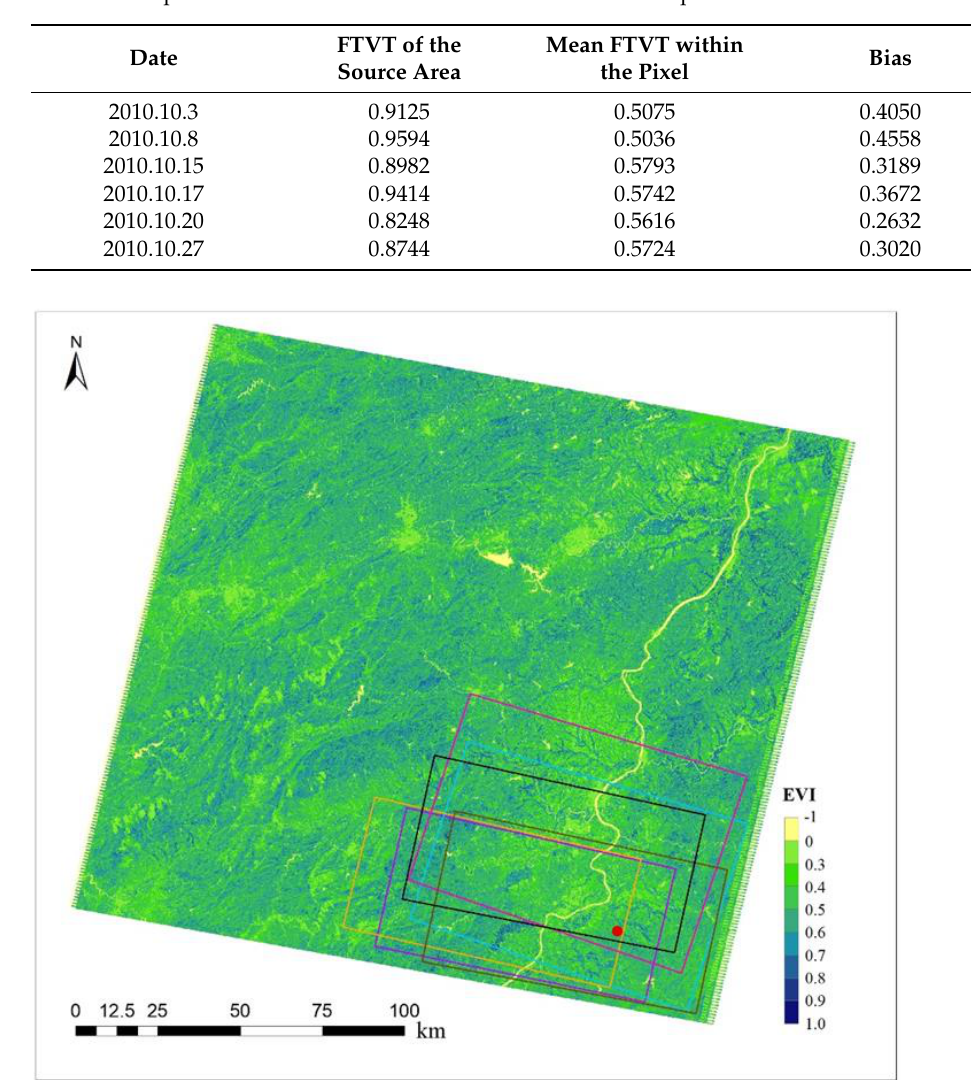
Table 3. Comparison of FTVT within the flux source area and the pixels of GOME-2 SIF data.